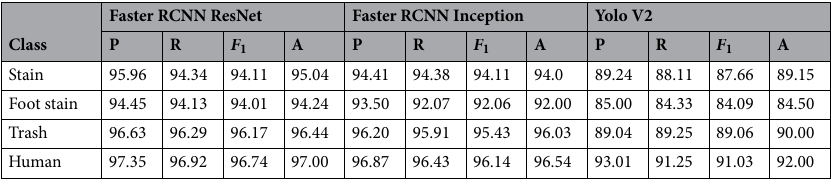
Table 3. Comparison with other object detection frameworks.